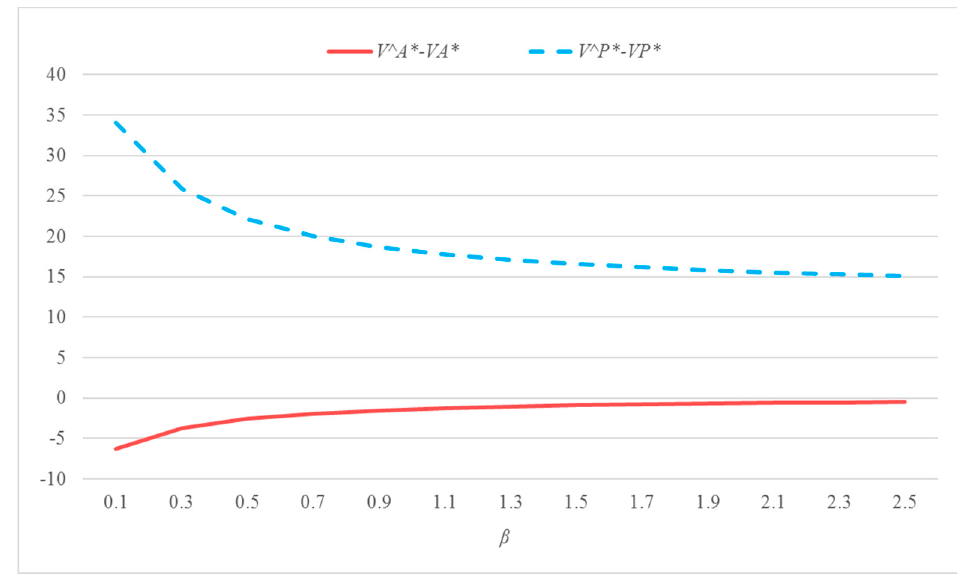
Figure 5. Part (iv): ˆ V ∗ and ˆ V ∗ . Notes: Figure 5 is generated based on P = 10, µ 1 = 0.1, µ 2 = 0.5, θ 1 = 0.1, θ 2 = 0.4, δ = 0.4, α = 0.5, η 1 = 0.3, η 2 = 0.5, λ = 0.4, ρ = 0.3, R 0 = 20, and G 0 = 200.